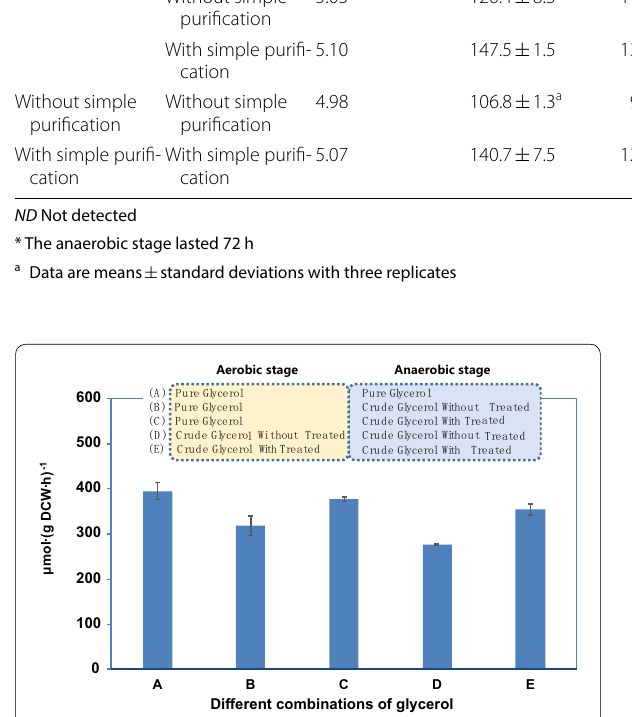
Fig. 2 Average specific productivity of succinate in the anaerobic stage in flask experiments. The combination of glycerol was based on the two-stage strategy. (A) Aerobic stage: pure glycerol, anaerobic stage: pure glycerol. (B) Aerobic stage: pure glycerol, anaerobic stage: crude glycerol without simple purification. (C) Aerobic stage: pure glycerol, anaerobic stage: crude glycerol with simple purification. (D) Aerobic stage: crude glycerol without simple purification, anaerobic stage: crude glycerol without simple purification. (E) Aerobic stage: crude glycerol with simple purification, anaerobic stage: crude glycerol with simple